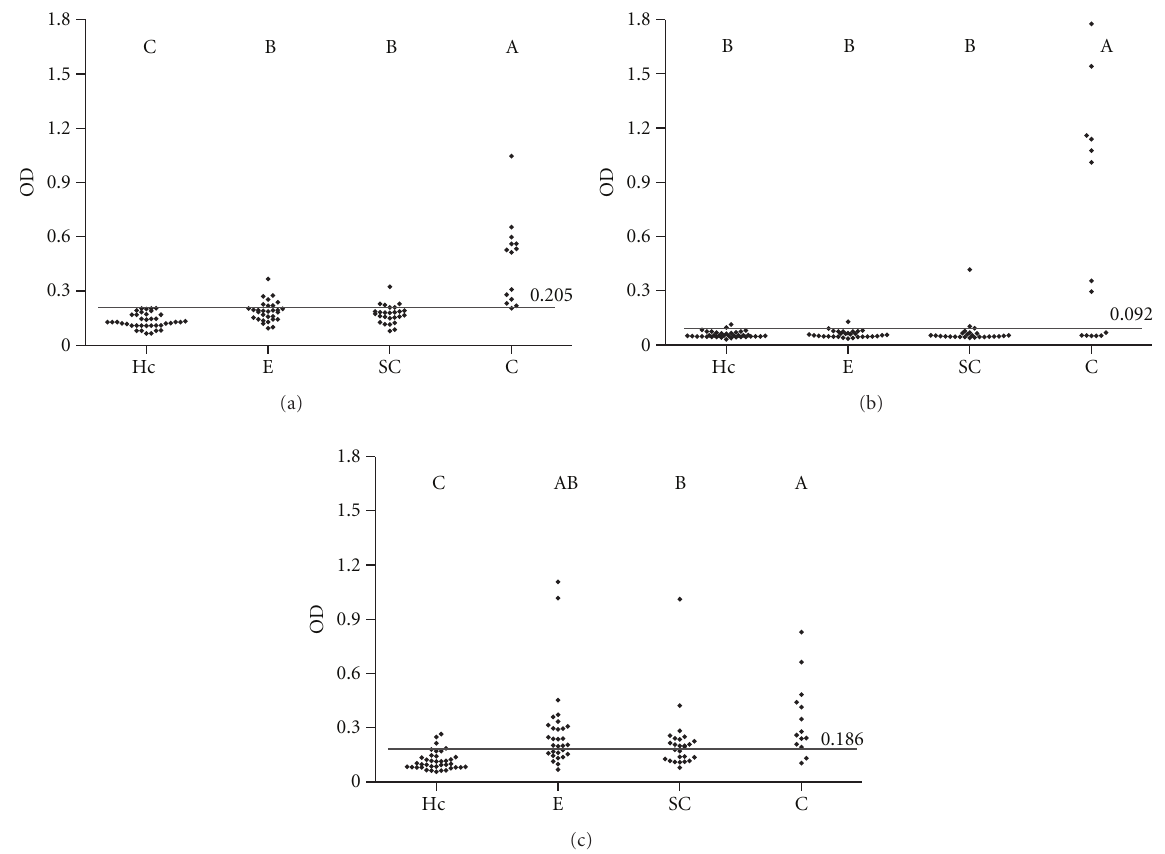
Figure 1: Results of isotypes/PPA-ELISAs. Dotplots of IgG (a), IgG1 (b), and IgG2 (c) PPA-ELISAs. Antibody responses are plotted as mean optical density (OD); lines and numbers (over lines) represent cut-o ff points. Letters indicate a significant di ff erence ( P < 0.05) between groups. Groups: healthy controls (Hc, n = 38), exposed (E, n = 30), subclinically infected (SC, n = 26), and clinically infected (C, n = 14).